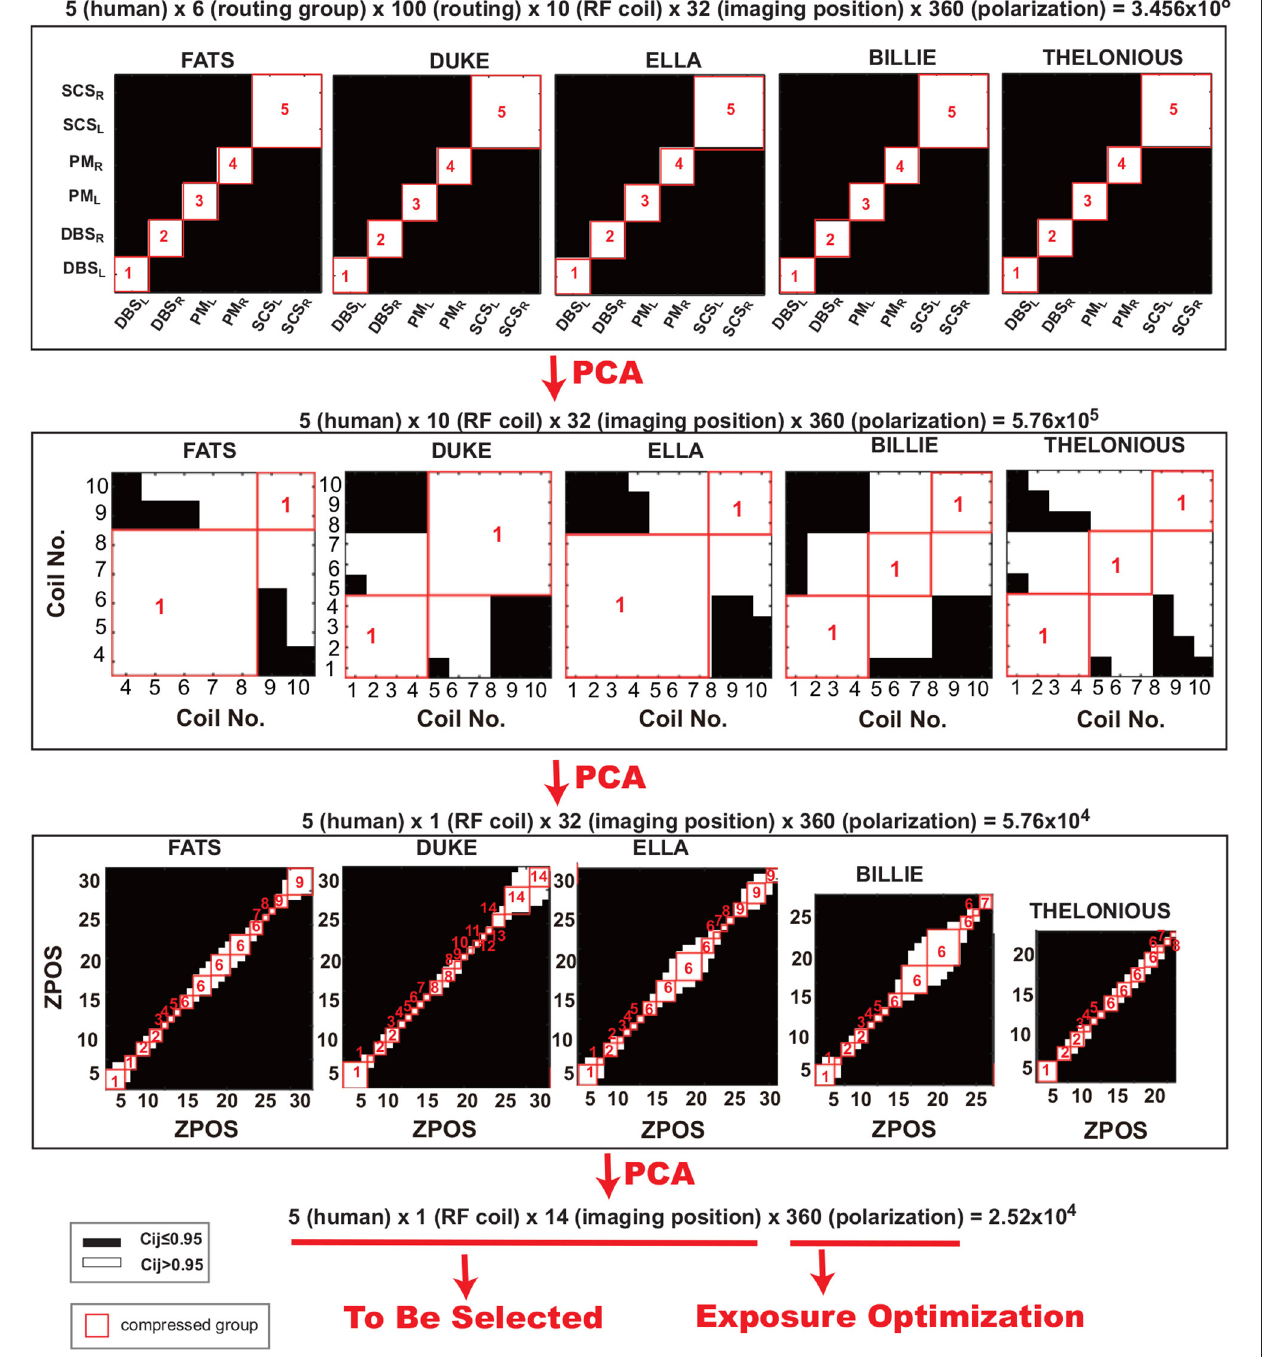
FIGURE 4 | Illustration of the principle component analysis (PCA) guided data compression procedure: covariance matrix C of implant routing (Top Row) , RF coil (Middle Row) , and imaging position (Botoom Row) are shown following the data compression order. from the redundant data. The PCA algorithm performed in this work is defined as